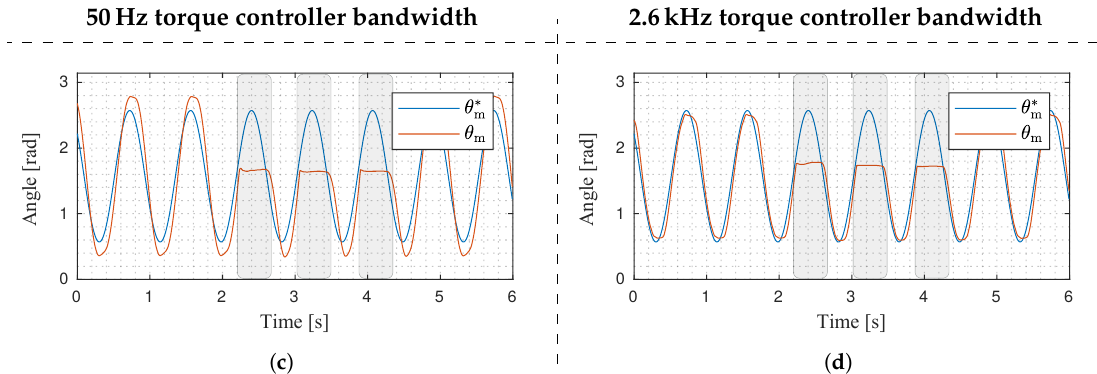
Figure 16. Measured and estimated results from two conducted experiments using active impedance mode with a sinusoidal angle reference and with a 30cm propeller. ( a , c ) is at reduced torque controller bandwidth (50Hz) and ( b , c ) is at the originally designed torque controller (50Hz). Both tests are performed including both the novel angle and speed observer and the torque observer. The three gray areas on each plot depict three human-robot collisions. These are performed by putting a human hand in the middle of the trajectory path for about three trajectory